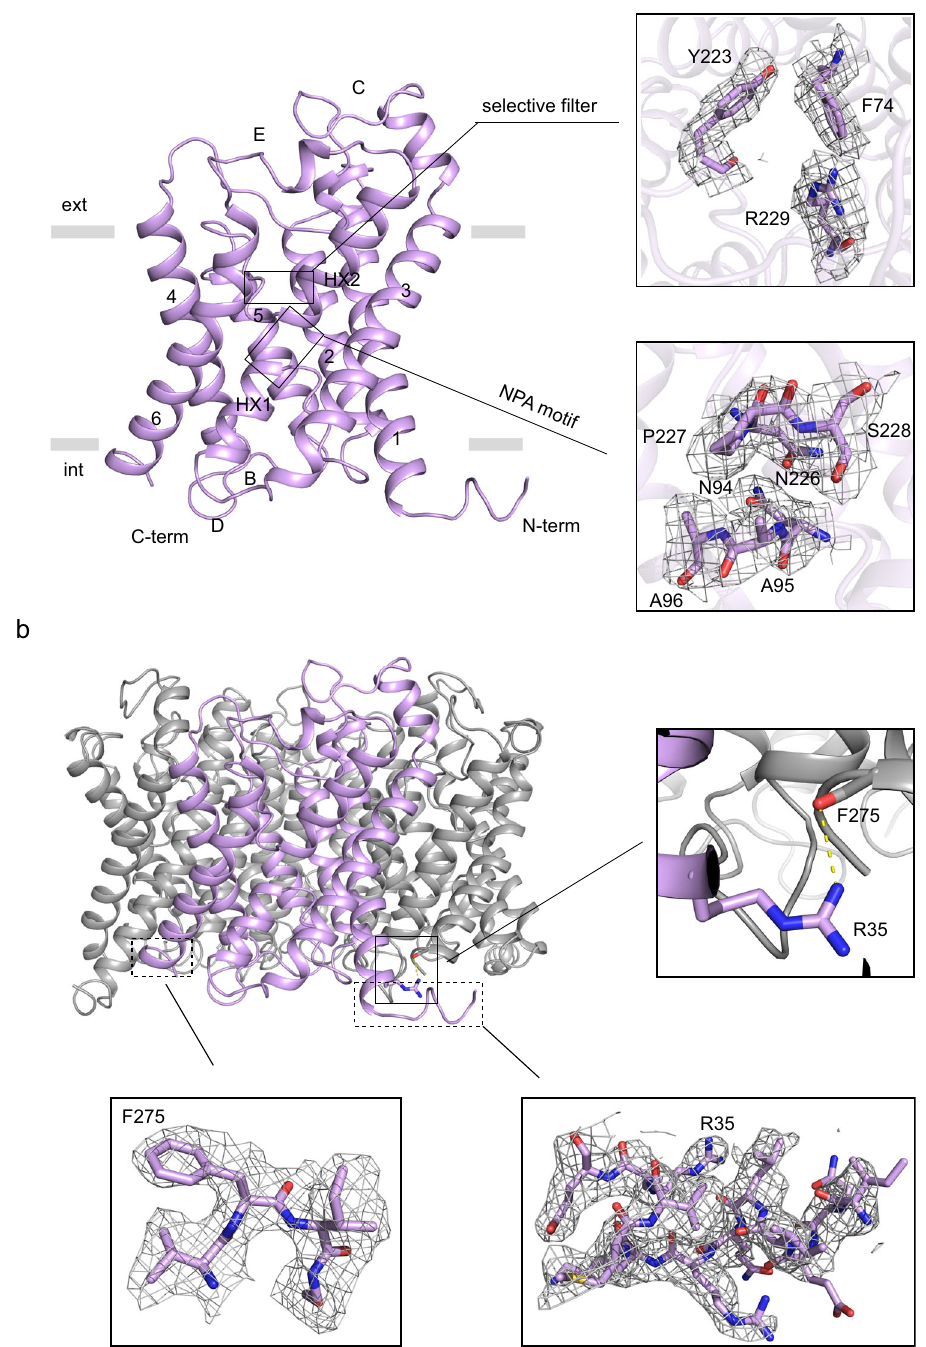
Fig. 3 | The termini stabilize the tetrameric con fi guration of AQP7. a Cartoon representationofthe consensusmonomer.Residuesofthe ar/R selective fi lterand NPA motifs are shown as sticks with corresponding cryo-EM density maps in gray. Transmembrane domains arerepresented by1 – 6 whilethetwohalf helices by HX1 andHX2,andloopsbyA-E. b Interactionbetweenneighboringmonomers(AandC)